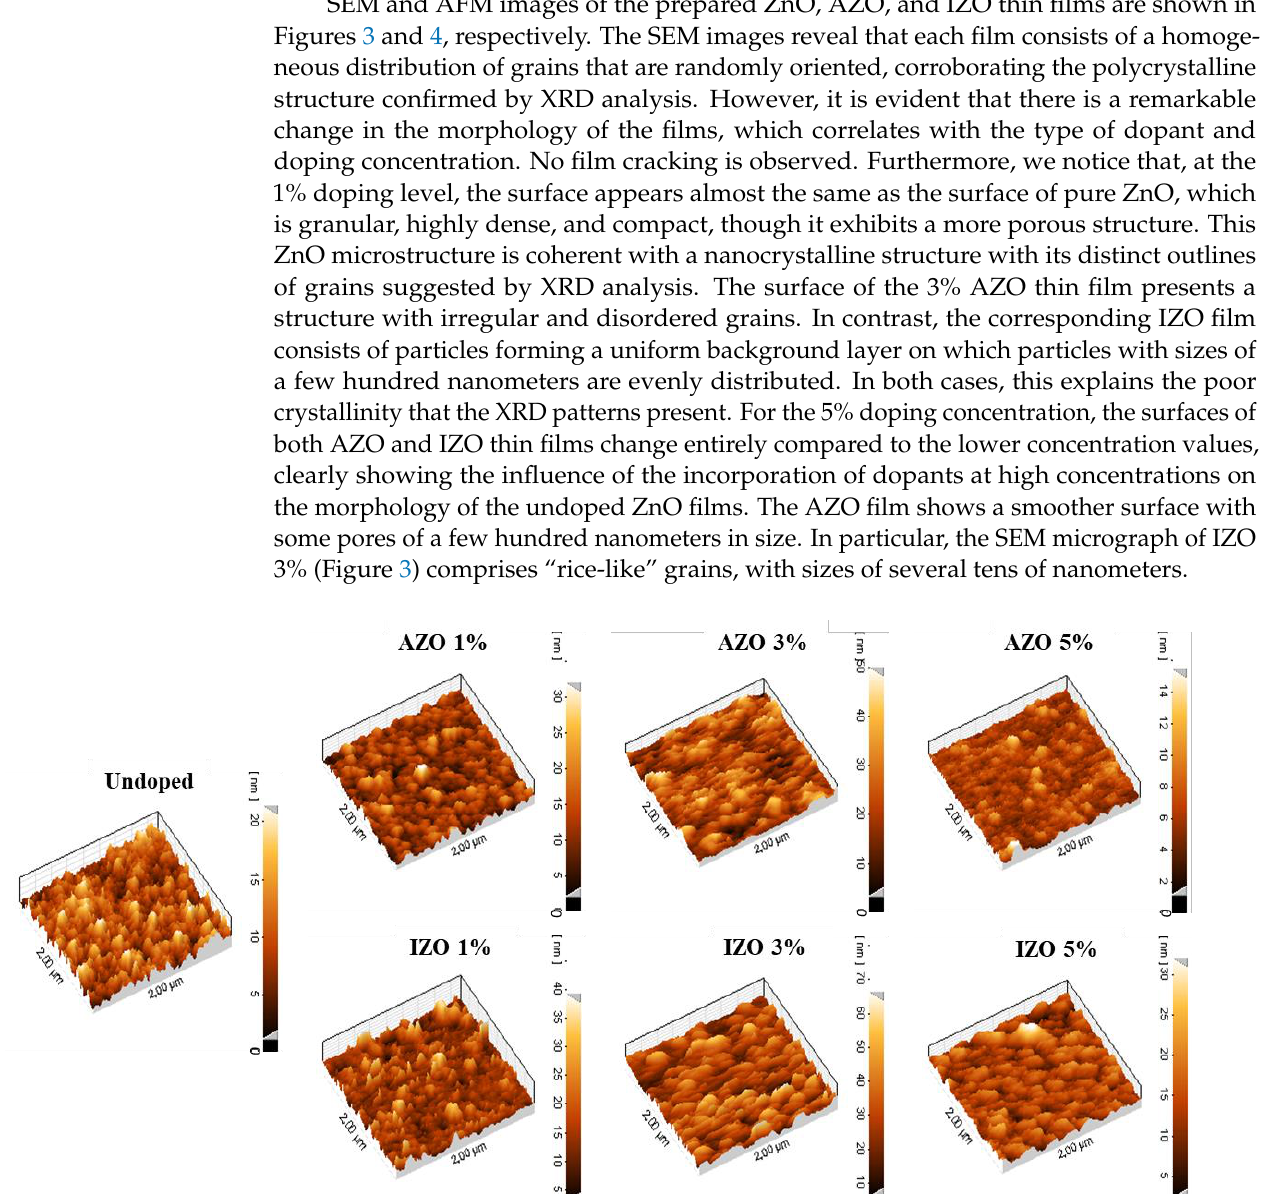
Table 2. Average and root mean square (rms) values of surface roughness measured using AFM.